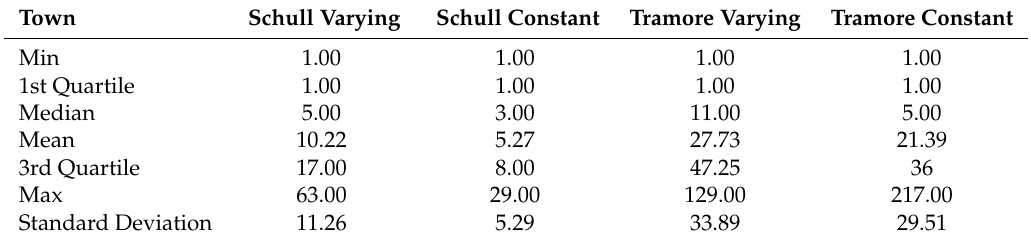
Table 3. Summary statistics for the number of agents infected per run for a steady versus a varying initial